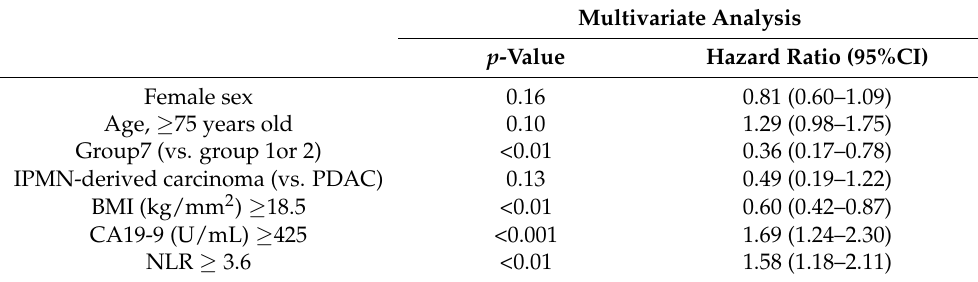
Table 4. Prognostic factors in patients in groups 1, 2,